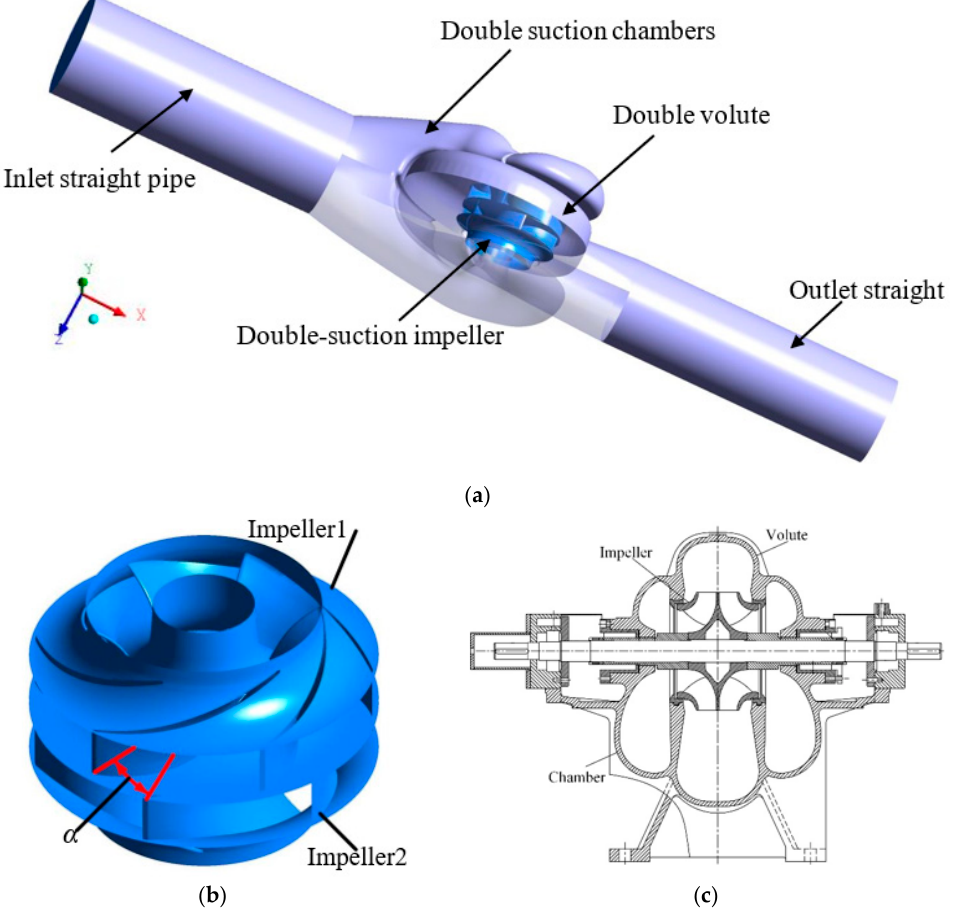
Figure 2. The geometry of the pump. ( a ) The computational domain; ( b ) Staggered angle; ( c ) Sketch of the pump.